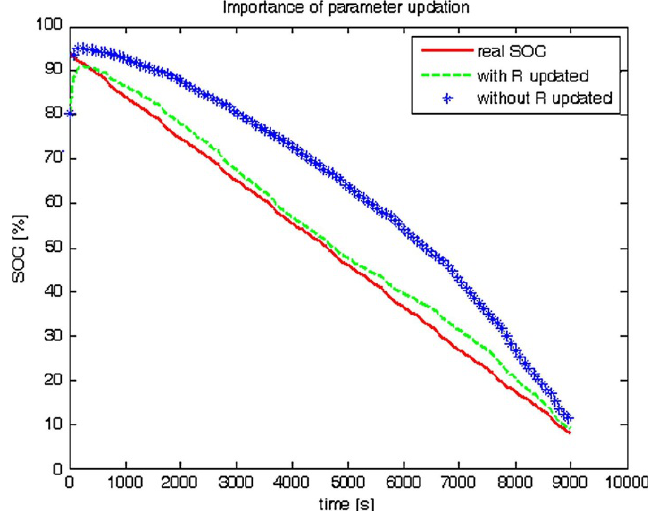
Figure 5. UKF-based SOC estimation with/without considering the battery aging